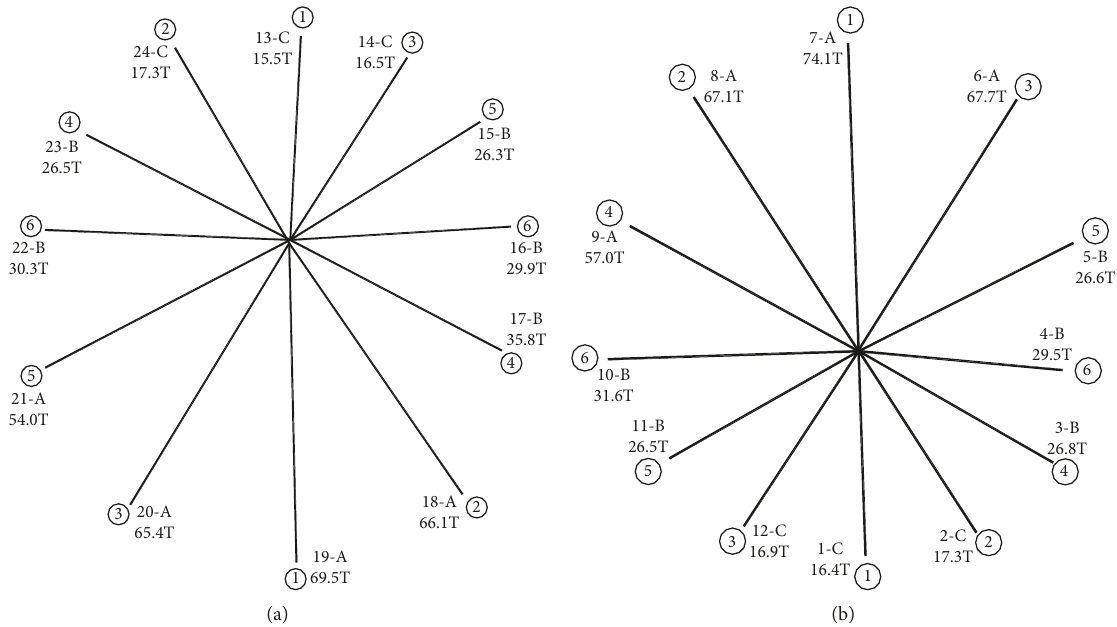
Figure 3: Weight chat of dendritic structure. (a) North tree. (b) South